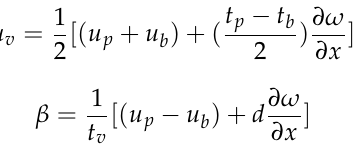
Figure 2. Geometric deformation relation of ACLD cantilever beam structure.